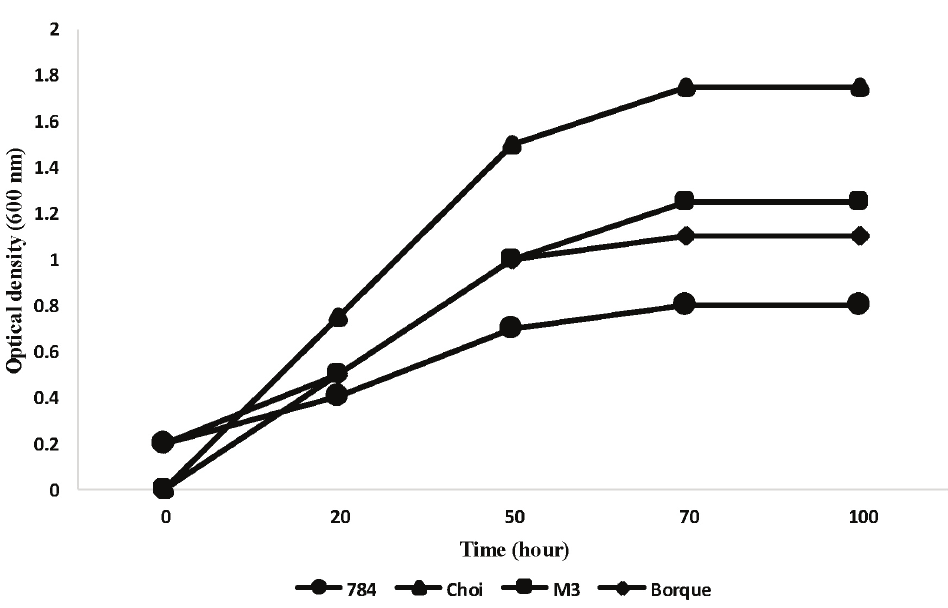
Fig. 2 – Growth curve of the isolated methanotroph for PHB production in a bubble column bioreactor in different media